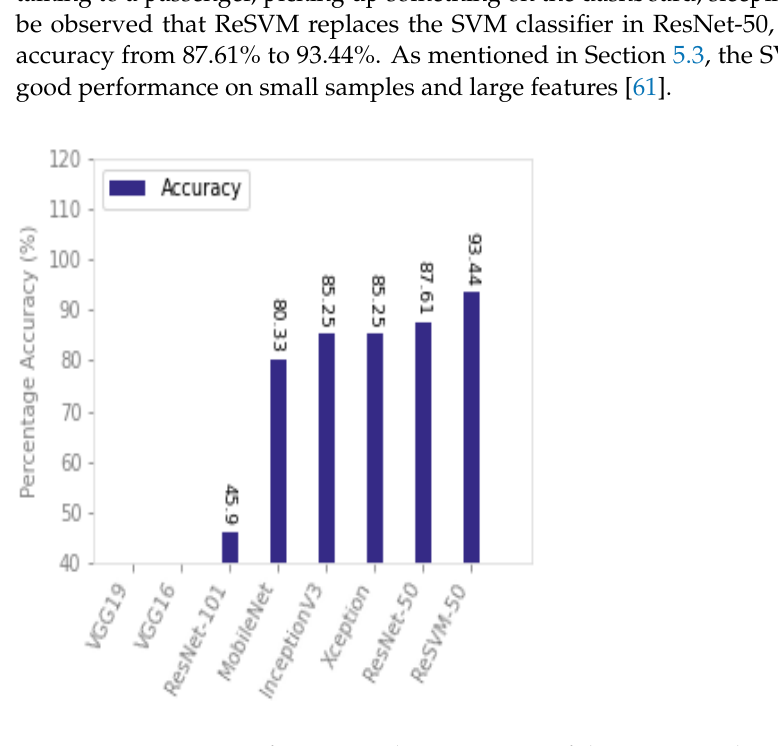
Figure 10. Comparison of ReSVM with existing state-of-the-art approaches in terms of percentage accuracy on DrivFace